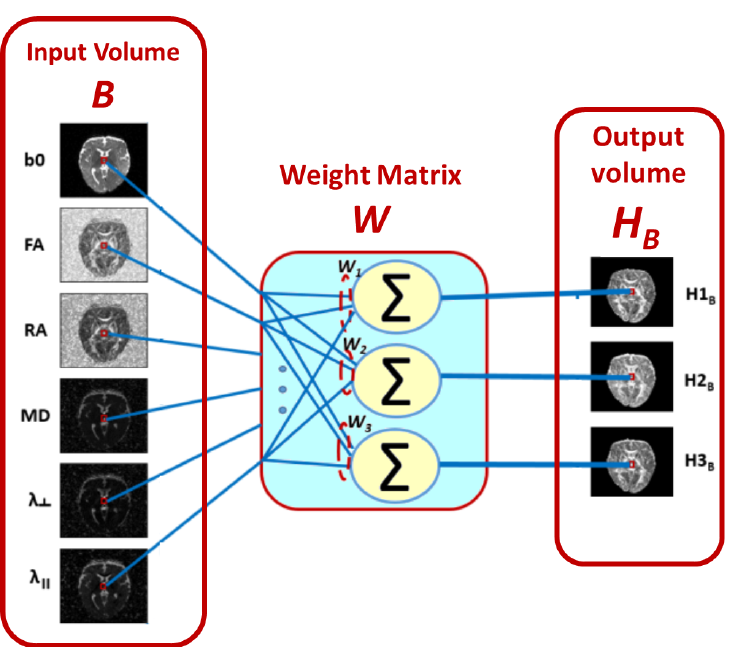
Figure 3. The NMF-based feature fusion block